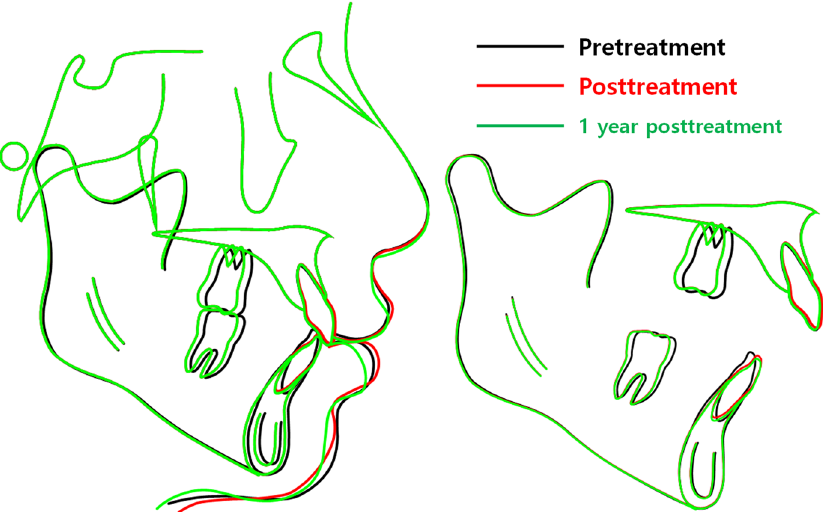
Figure 5. Superimposition of the lateral cephalograms at pre-treatment (black), post-treatment (red), 1 year post-treatment